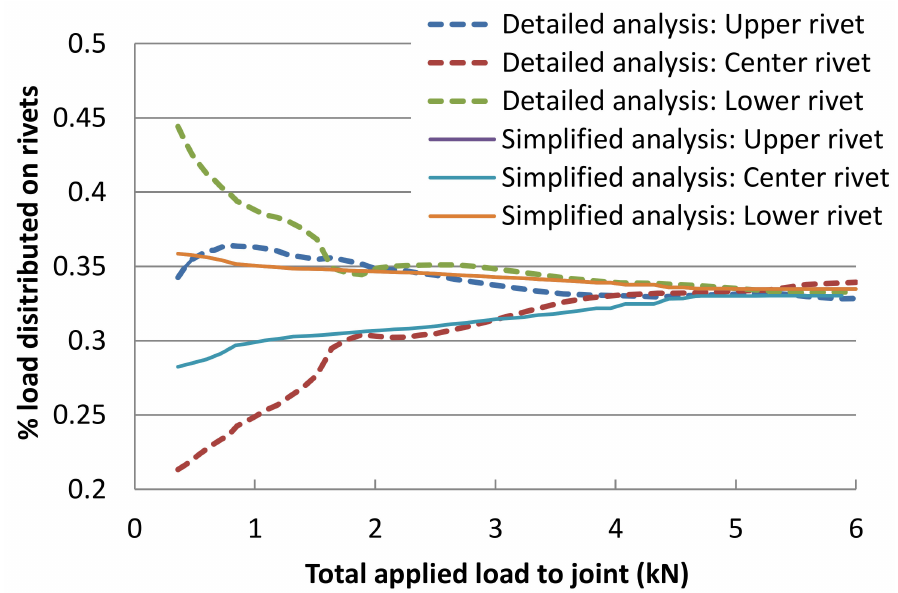
Figure 18. Ratio of distributed loads on each rivet to total applied load to the triple-row